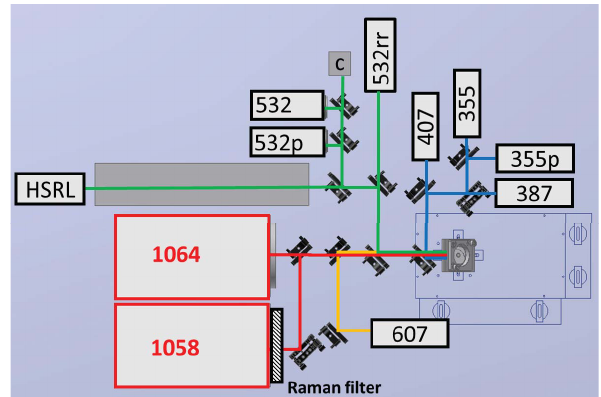
Figure 1. Sketch of the receiver unit of the lidar BERTHA with 13 detection channels (all operated in the photon counting mode): three elastic backscatter channels (355, 532 and 1064nm), two cross- polarized elastic backscatter channels (355p, 532p, index p for per- pendicular), two nitrogen vibrational–rotational Raman channels (387 and 607nm), three rotational Raman channels (532rr, grating monochromator technique) (Arshinov et al., 2005), one rotational Raman channel (1058nm), a water-vapor vibrational–rotational Ra- man channel at 407nm and a HSRL channel at 532nm. All detec- tors are photomultiplier tubes (PMTs) from Hamamatsu (H10721P- 110, except for 1058 and 1064nm). For the 1058 and 1064nm chan- nels the PMTs R3236 from Hamamatsu are used. To reduce the signal-to-noise ratio, they are cooled down to lower than − 30 ◦